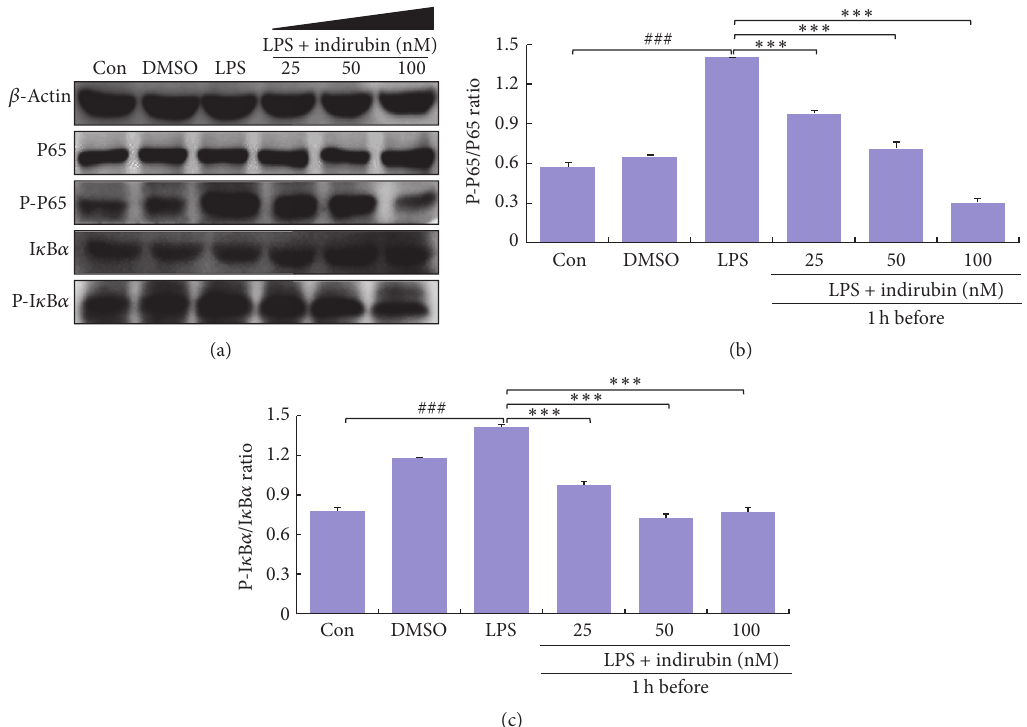
Figure 6: Effects of indirubin on phosphorylation of I 𝜅 B 𝛼 and NF- 𝜅 B P65 in LPS-induced MMECs. (a) Cells proteins I 𝜅 B 𝛼 and NF- 𝜅 B P65 were analyzed by western blotting. (b) Densitometric analysis of NF- 𝜅 B P-P65/P65. (c) Densitometric analysis of p-I 𝜅 B 𝛼 /I 𝜅 B 𝛼 . The values are presented as means ± SEM ( 𝑛 = 3 ). ### 𝑝 < 0.001 versus control group; ∗∗∗ 𝑝 < 0.001 versus LPS